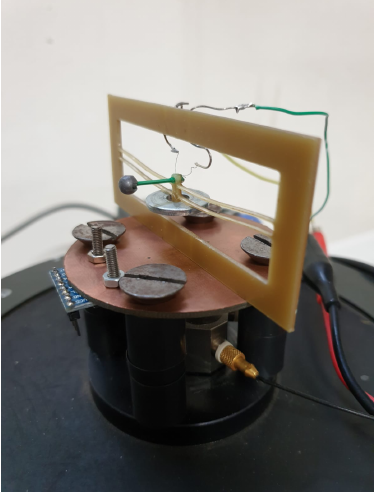
Figure 15. Experimental setup used to characterize Model B with the additional mass on the electrodynamic